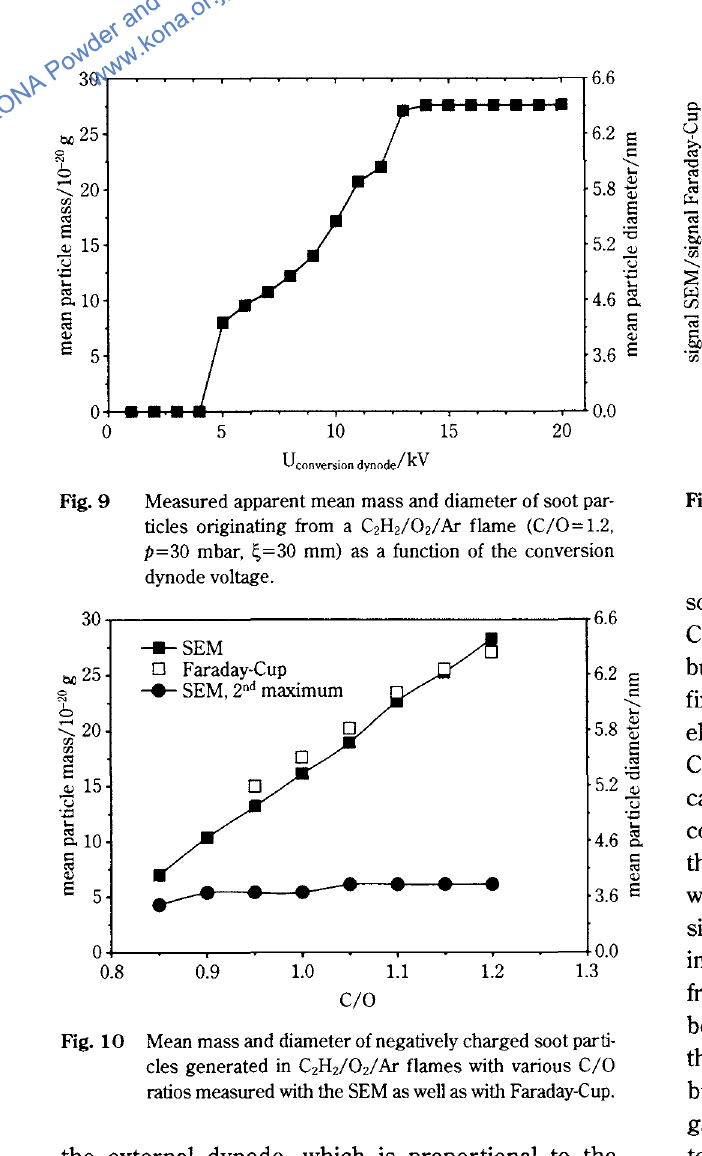
Fig. 11 Relative signal gain (Ir.sEMIIr.Faraday-Cup) as a function of the flow coordinate. soot particles, generated in C H /0 2/ Ar flames with 2 2 C/0 ratios of 0.85:5 C/0 :51.2. The flames were burned at 30 mbar and the samples were taken at a fixed flow coordinate of s=30 mm. The secondary electron multiplier (closed symbols) and the Faraday Cup (open symbols) measurements show no signifi cant differences in size for C/0 > 0.95, indicating the correctness of the multiplier transfer function. Due to the much larger signal of the multiplier compared with the Faraday-Cup measurements, it was also pos sible to detect soot particles for extremely mild soot ing conditions. Furthermore, an additional particle fraction of dp=3.6 nm was identified, which could not be resolved by the Faraday-Cup device. The size of this particle class seems to be independent of the burning conditions of the sooting flames. The overall gain in the particle current obtained by the multiplier technique is summarized in Fig. 11. The particle flux measured with the SEM is related to the particle flux measured with the Faraday-Cup as a function of the flow coordinate S· The signal gain for positively charged particles is about 104, whereas negatively charged particles lead to a multiplier current which is always larger than 10 4 •